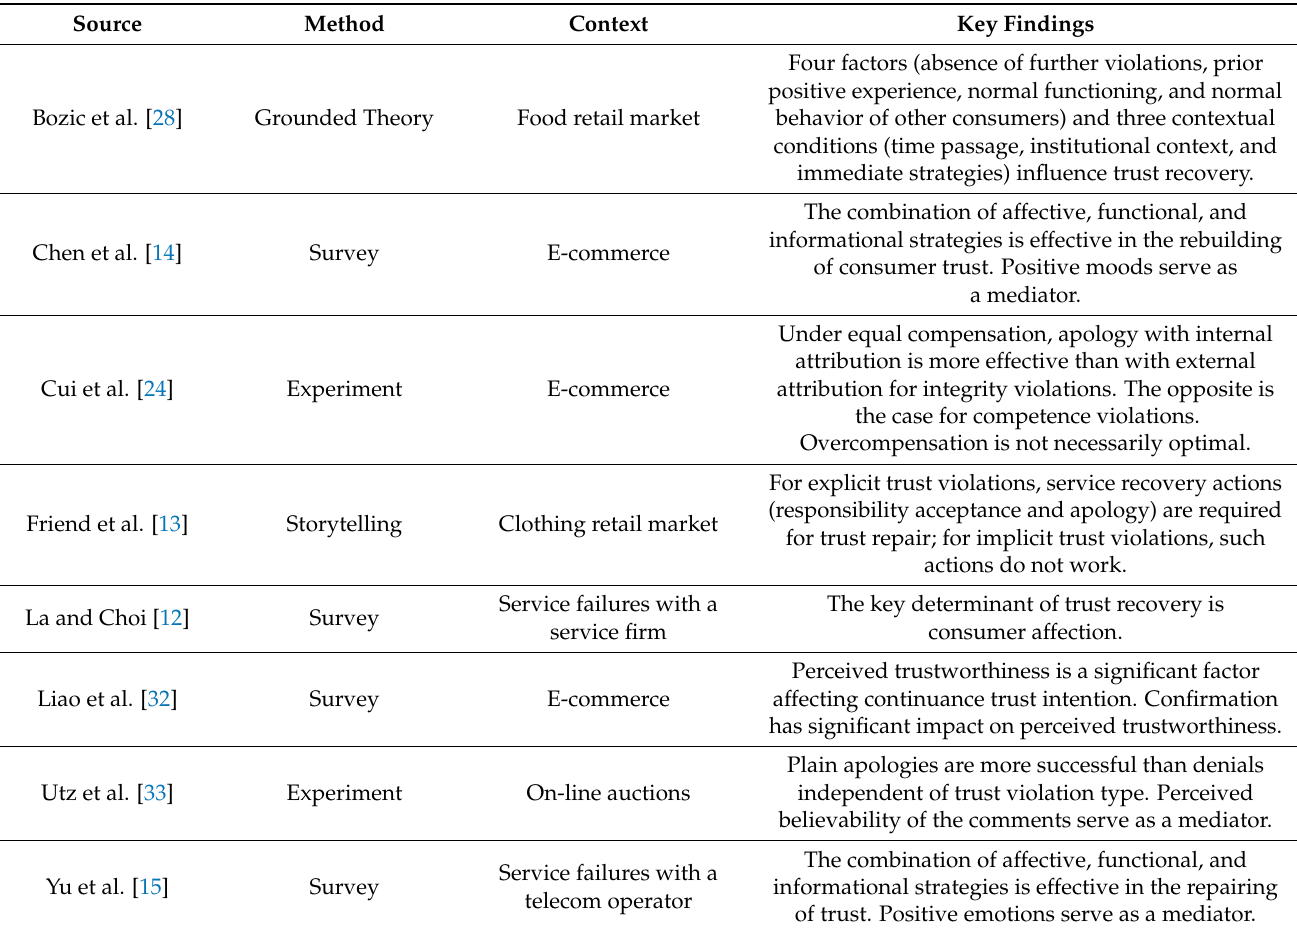
Table 1. Literature on the trust repair in buyer–seller